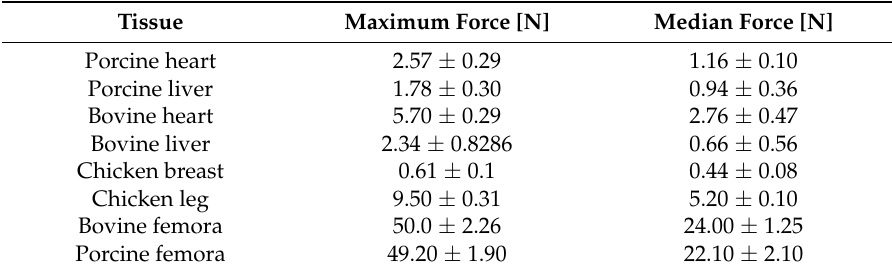
Table 1. Puncture force associated with different tissue types.